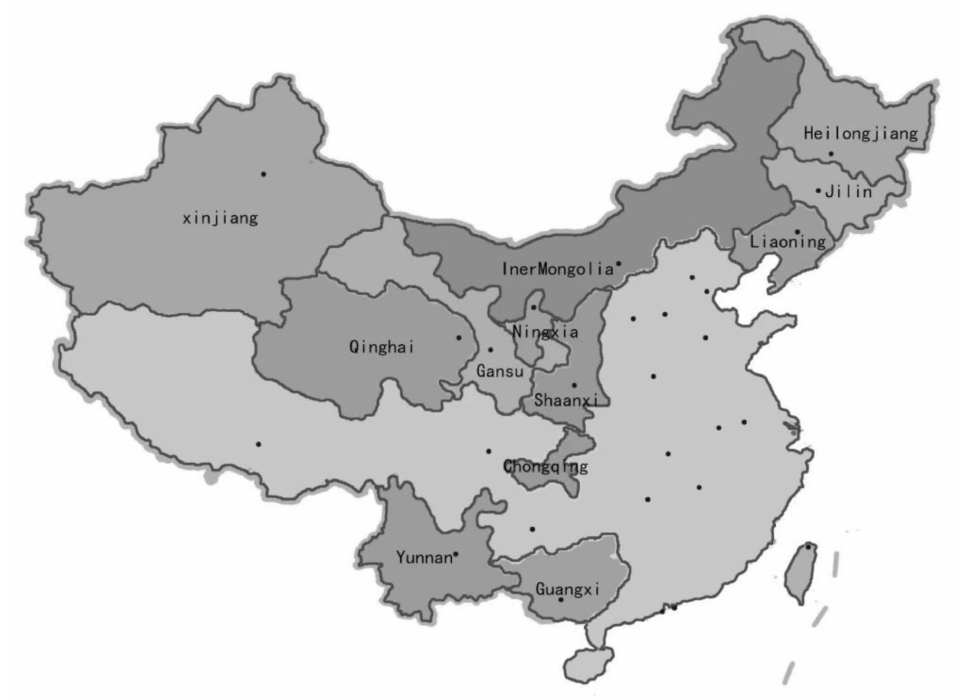
Figure 1. Geographical locations of the Chinese provinces along the SREB. Adapted from